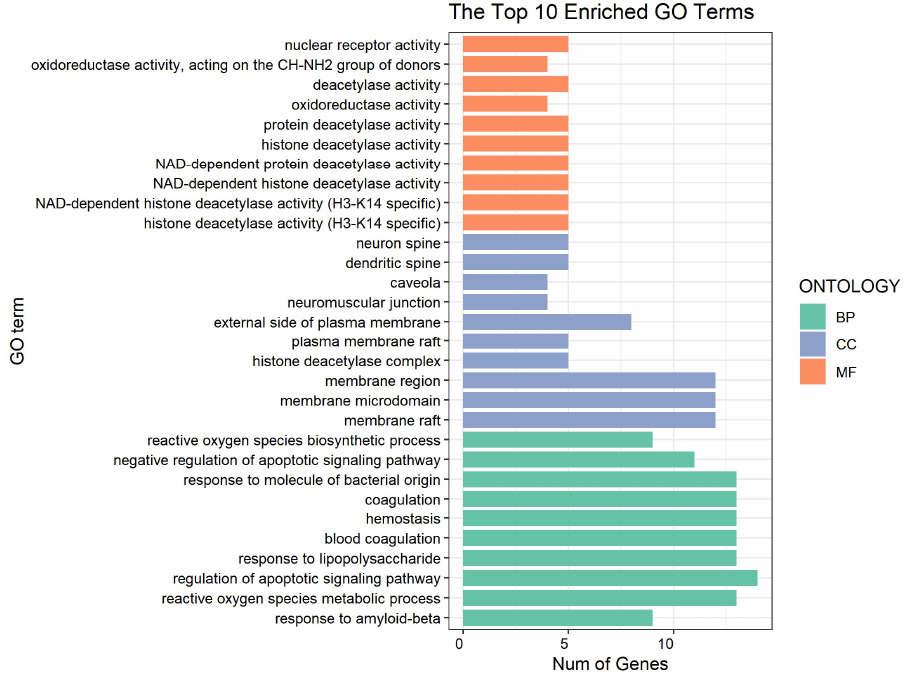
Figure 5. Gene ontology (GO) enrichment showing the top ten enriched terms in three categories: molecular function (MF), cellular component (CC) and biological process (BP). The x-axis represents the number of enriched genes in each term; the y-axis represents enriched terms in each category.